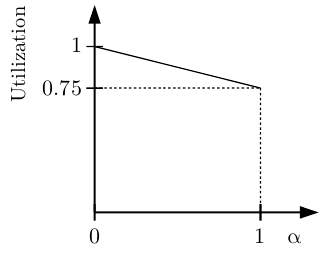
Figure 6. Efficiency-fairness graph for scenario in Figure 5, based on Ref.